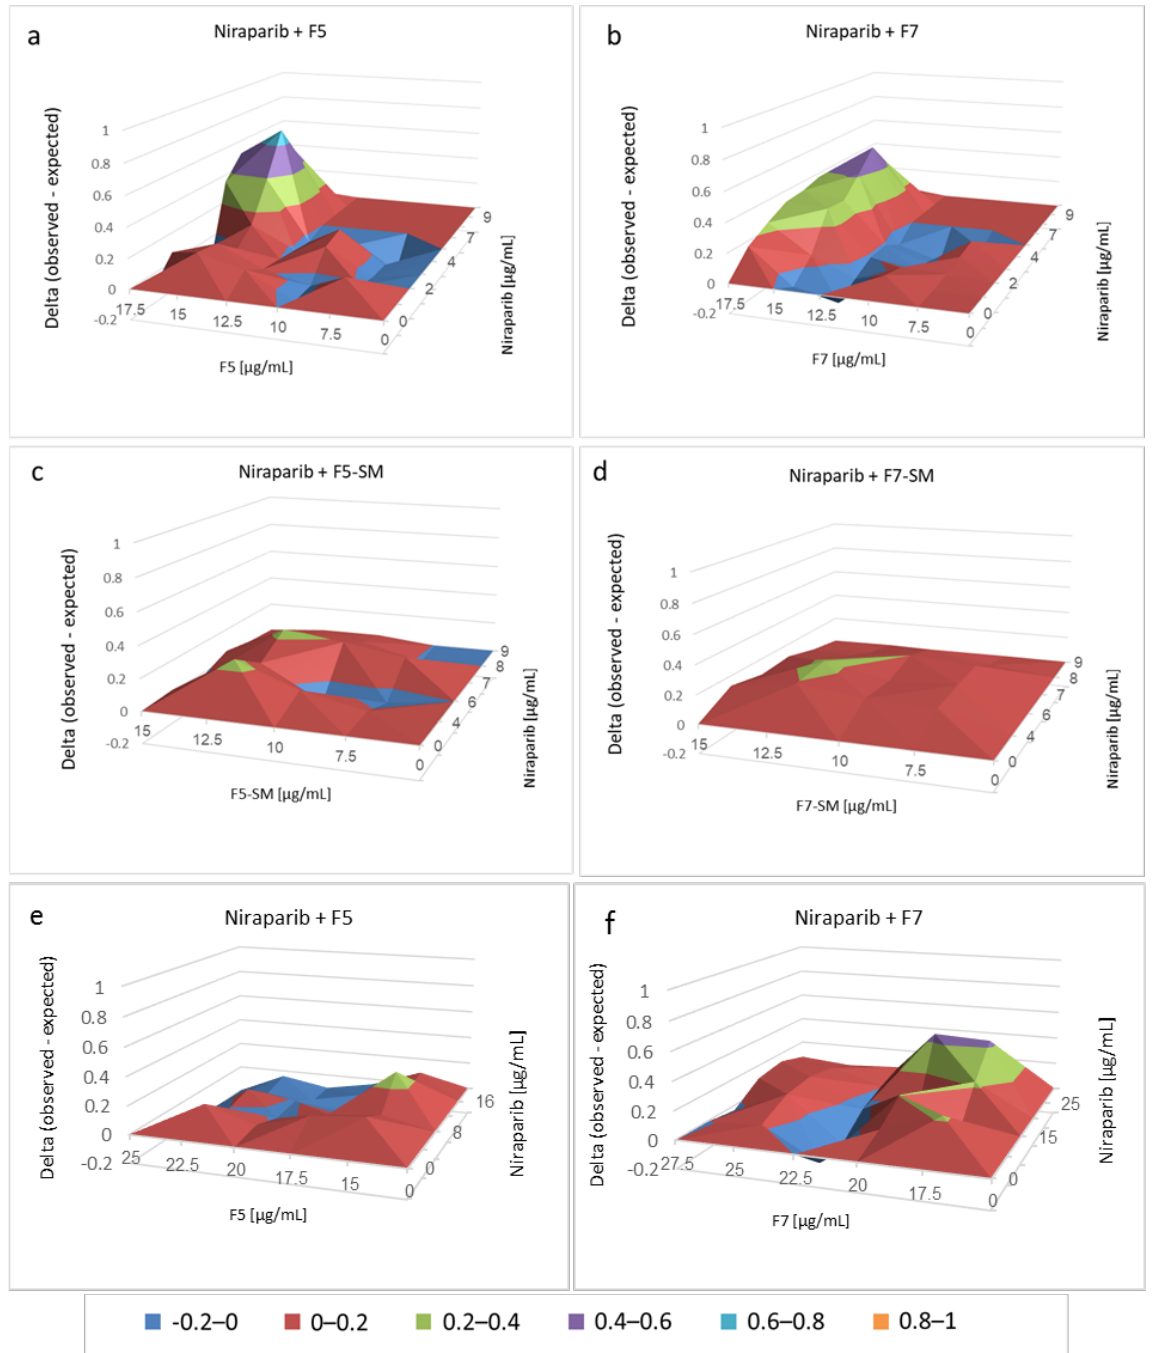
Figure 7. Synergistic interactions between F5, F7, F5-SM or F7-SM with niraparib on HTB75 cell viability at 48 h ( a – d ) and F5 or F7 with niraparib on HTB161 cell viability at 48 h ( e , f ) following combined treatments. Synergy of cytotoxic activity was calculated, based on the Bliss independence drug interaction model. Control was vehicle control (1.50% v/v methanol + 0.90% v/v DMSO for HTB75 and 1.38% v/v methanol + 2.50% v/v DMSO for HTB161). Synergy was apparent when the ex- perimental (observed) value of cell survival inhibition was higher than the calculated (expected) value. Delta values of observed minus expected are shown on the Y axis. Supplementary Tables S4 and S5 present the significantly different synergistic delta values of F5, F7, F5-SM or F7-SM with niraparib from all pair combinations according to the Tukey–Kramer honest significant difference test ( n = 3; HSD; p ≤